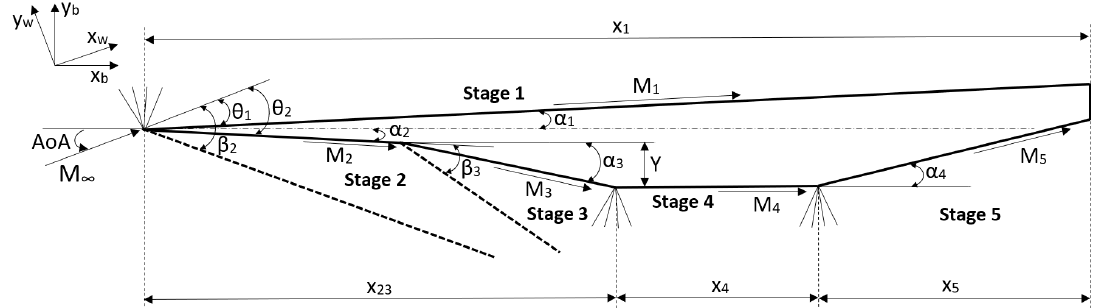
Figure 1. Oblique shock waves and Prandtl–Meyer expansion waves on the simplified shape of